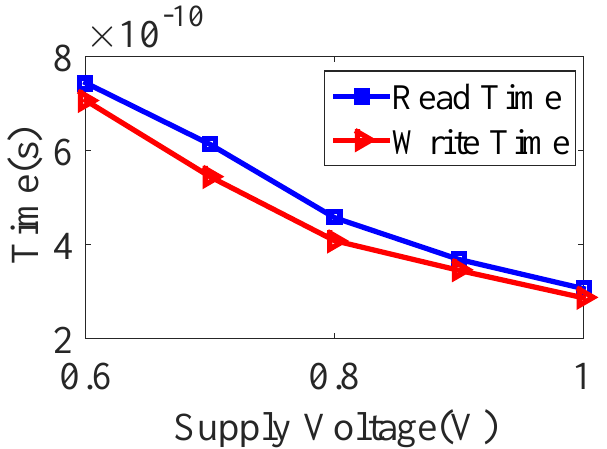
Figure 28. Simulation results for read and write performance at different supply voltages.